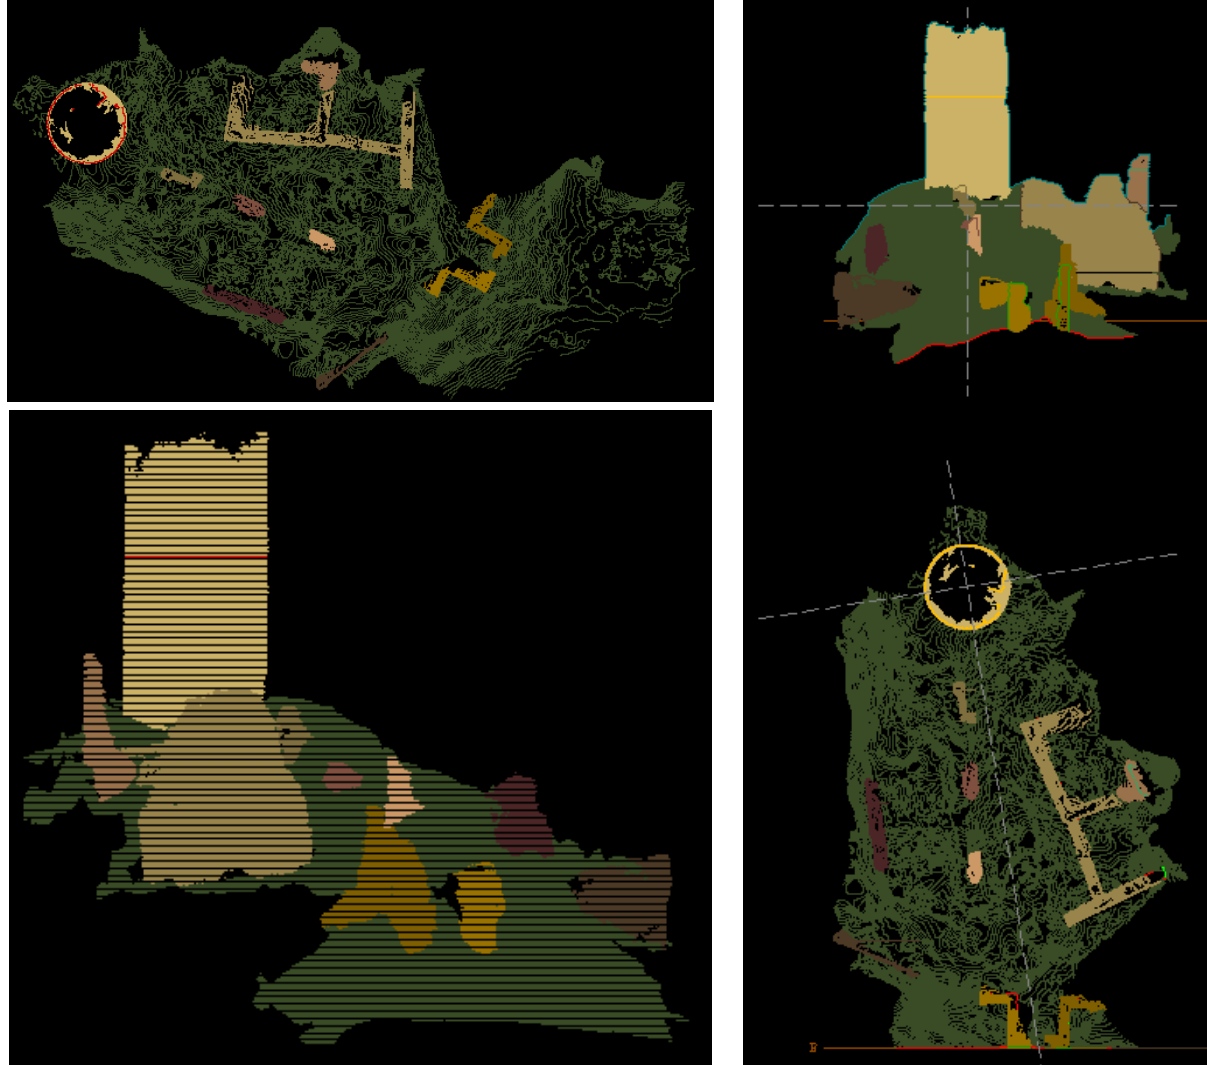
Figure 15: Contours (10 cm interval) and sections realized for architectural purposes and to create conservation and restoration